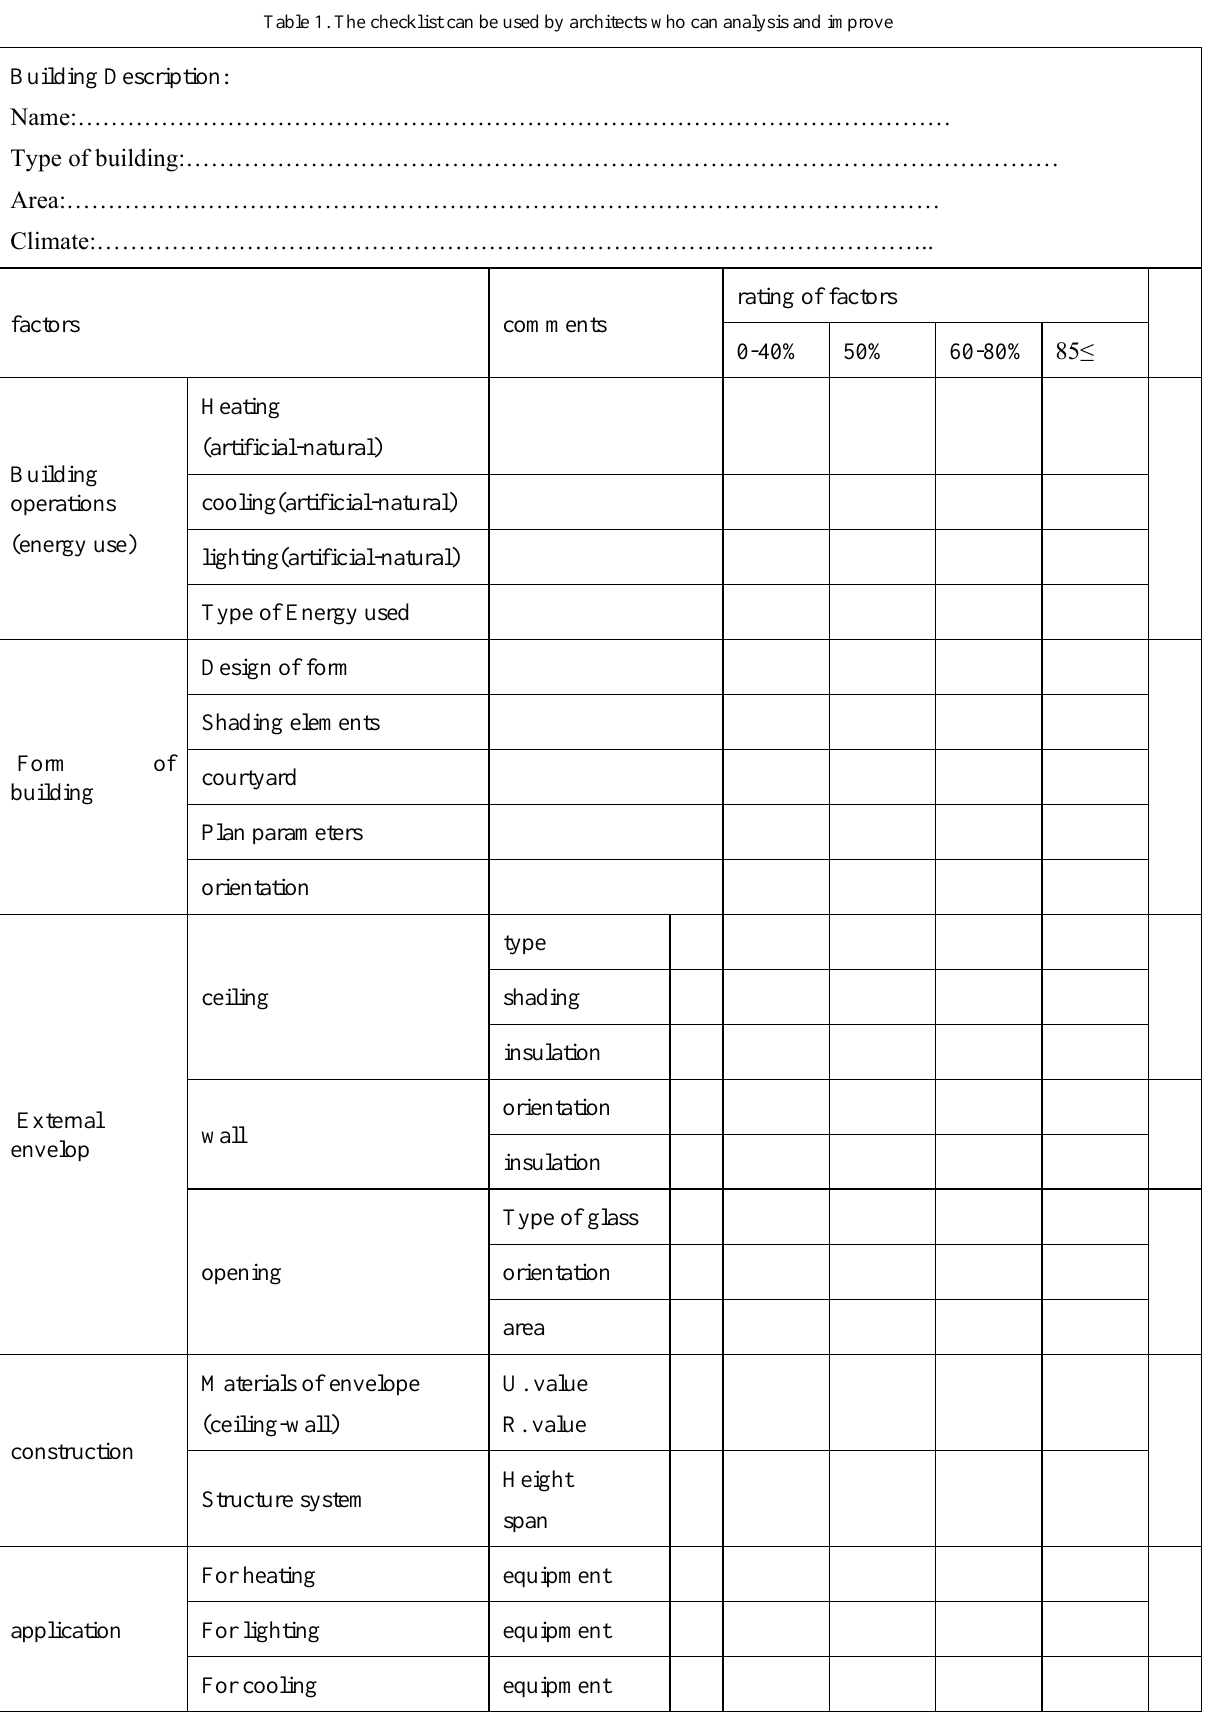
Table 1. The checklist can be used by architects who can analysis and improve Building